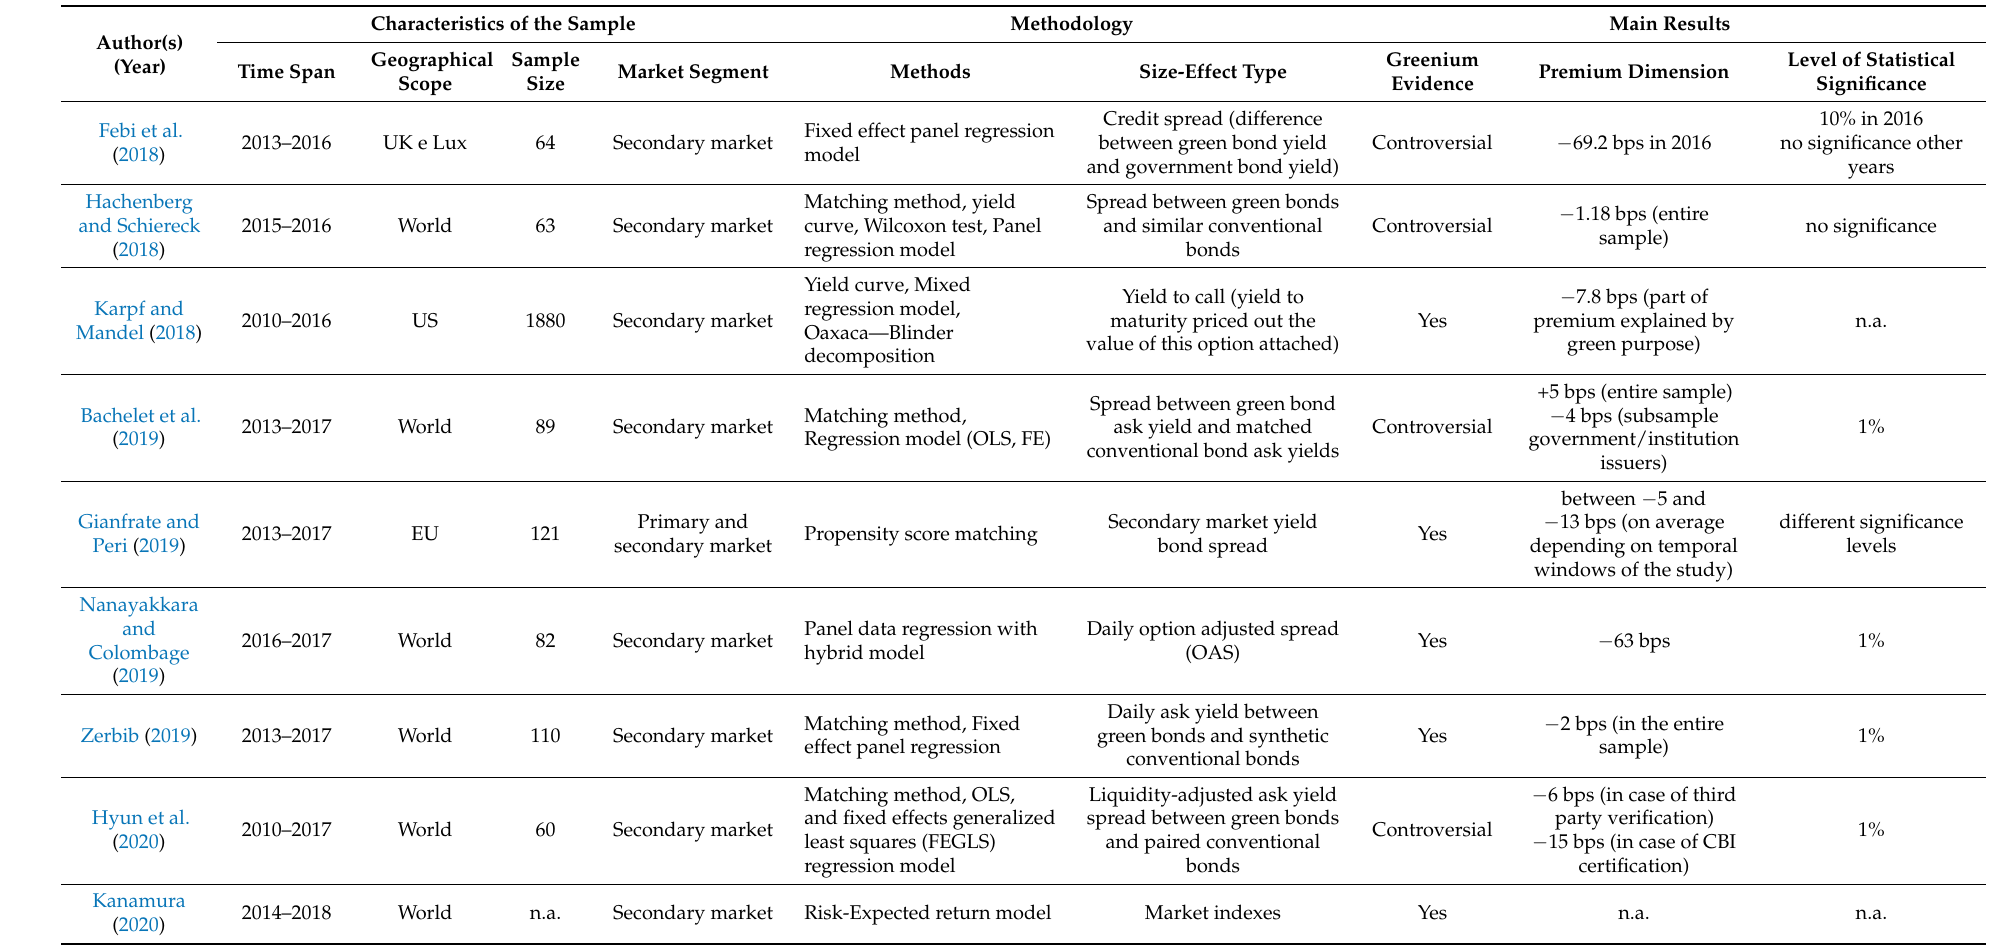
Table 5. Green premium empirical literature by the type of sample, methodology, and main